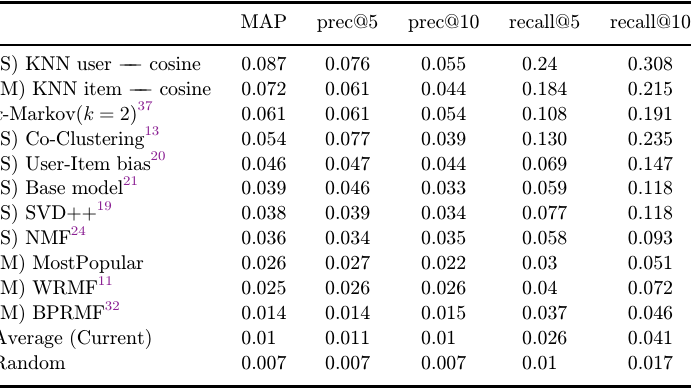
Table 3. Results for the top-10 recommendation task. (M) denotes a MyMedia- Lite implementation and (S) denotes a surprise implementation. MAP